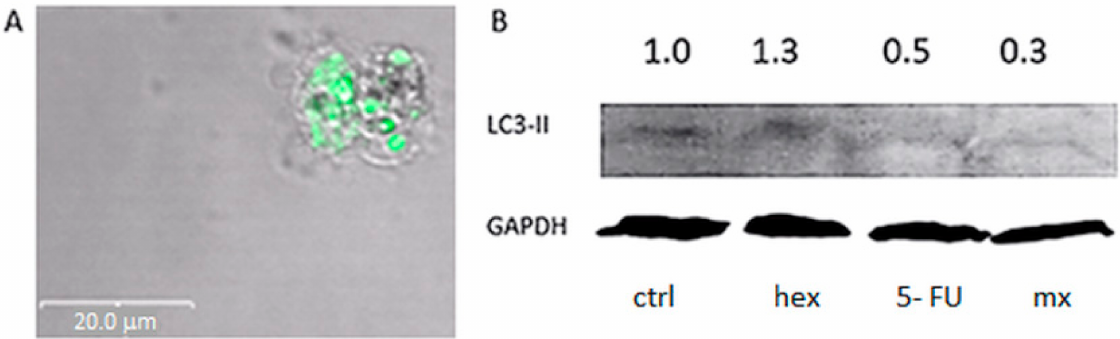
Figure 5. Autophagy detection: visualization of autophagic vacuoles in cells after the combined treatment with 2-oxohexyl ITC (hex) and 5-FU ( A ). Protein expression of LC3-II. GAPDH was a loading control. Protein levels were evaluated by the Western blot method ( B